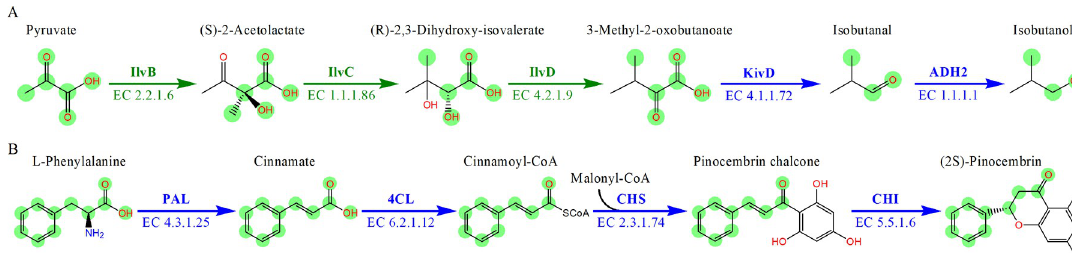
Fig 6. The top-ranked biosynthesis pathways of isobutanol and pinocembrin retrieved by PyMiner. (A) The biosynthetic pathway to produce isobutanol from pyruvate in E. coli. (B) The biosynthetic pathway to produce pinocembrin from L-phenylalanine in S. cerevisiae. The green arrows indicate endogenous steps while the blue arrows denote exogenous steps. The green circles highlight the atom transfer route from the initial substrate to the target product. And the EC number of each step is indicated below the arrow. Enzyme names are: IlvB, acetolactate synthase; IlvC, ketol-acid reductoisomerase; IlvD, dihydroxy-acid dehydratase; KivD, α - ketoisovalerate decarboxylase; ADH2, alcohol dehydrogenase; PAL, phenylalanine ammonia lyase; 4CL, cinnamoyl-CoA ligase; CHS, chalcone synthase; and CHI, chalcone